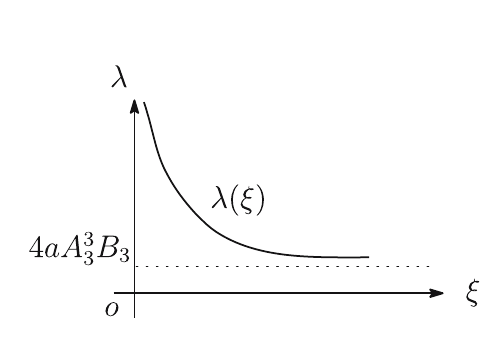
Figure 4: The graph of λ ξ ( ) for p 3 =